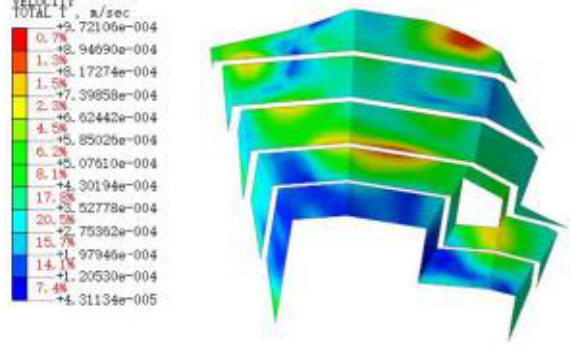
Figure 20. The vibration velocities of retaining walls at 800 ms.